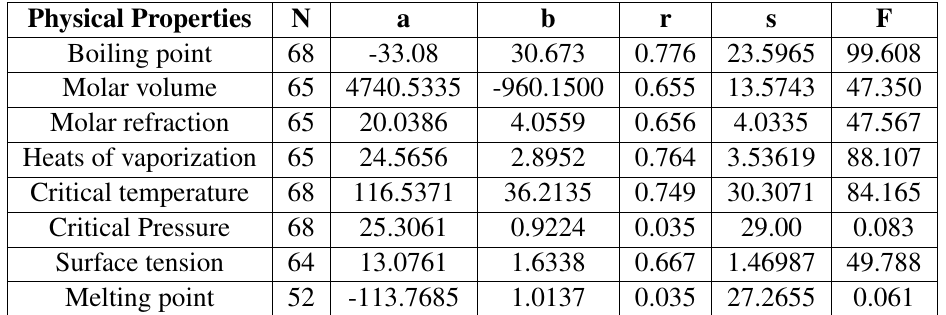
Table 11. Statical parameters for the linear QSPR model for R ( G )